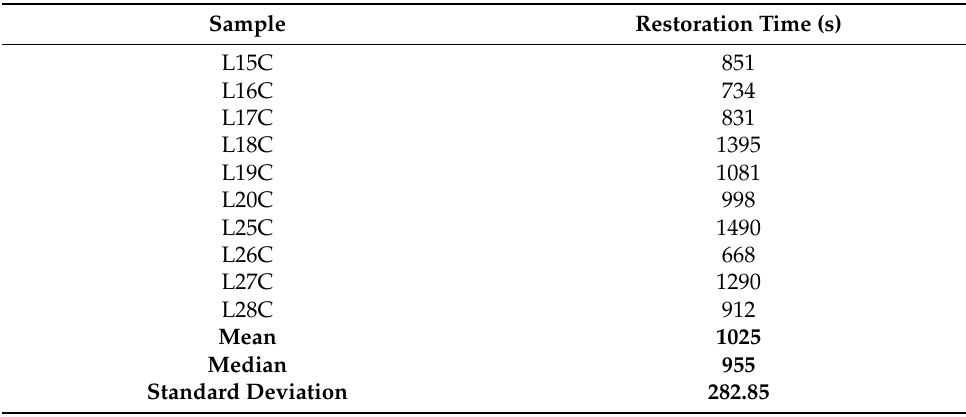
Table 10. Restoration time data in the control group.